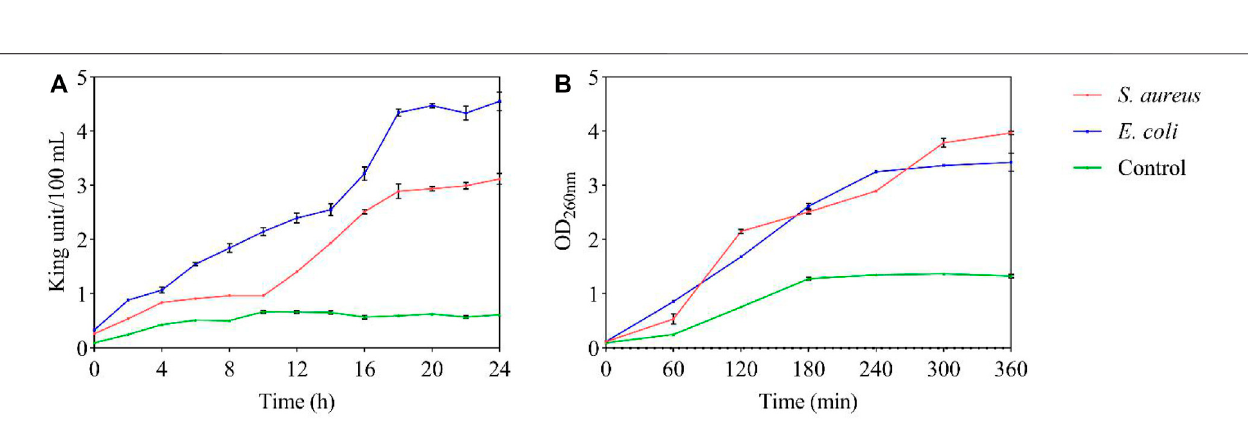
FIGURE 5 | Antibacterial mechanism of FC at MIC on test bacteria (A) : Cell wall permeability; (B) : Membrane integrity).